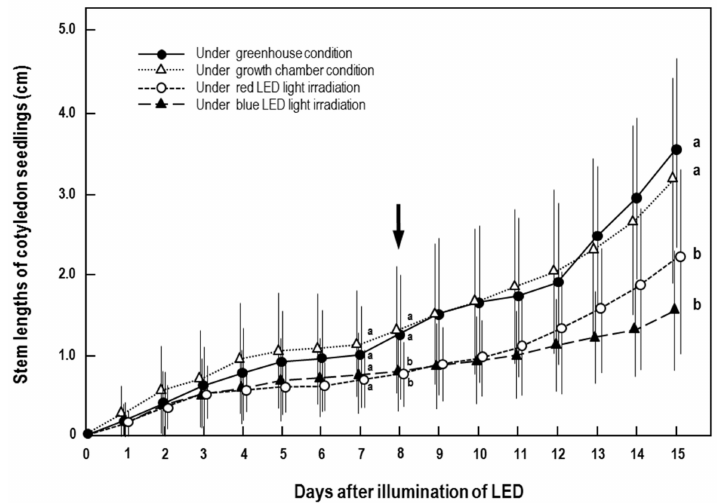
Figure 4. Continuous changes in melon seedling development from the cotyledon to three-true unfolded leaves stages during irradiation under red or blue LEDs. Melon seedlings grown under greenhouse and growth chamber conditions were used as controls. Stem length was measured repeatedly in the same melon seedlings treated under each condition for a period of 15 days. The black arrow indicates days showing significant differences in melon seedling growth among the four seedling groups. Data are means ± SDs of five replicates. Different letters indicate significant differences ( p < 0.05, Tukey’s test). Table 3. Effects of light quality on melon seedling growth under irradiation with red or blue light for 15 days.